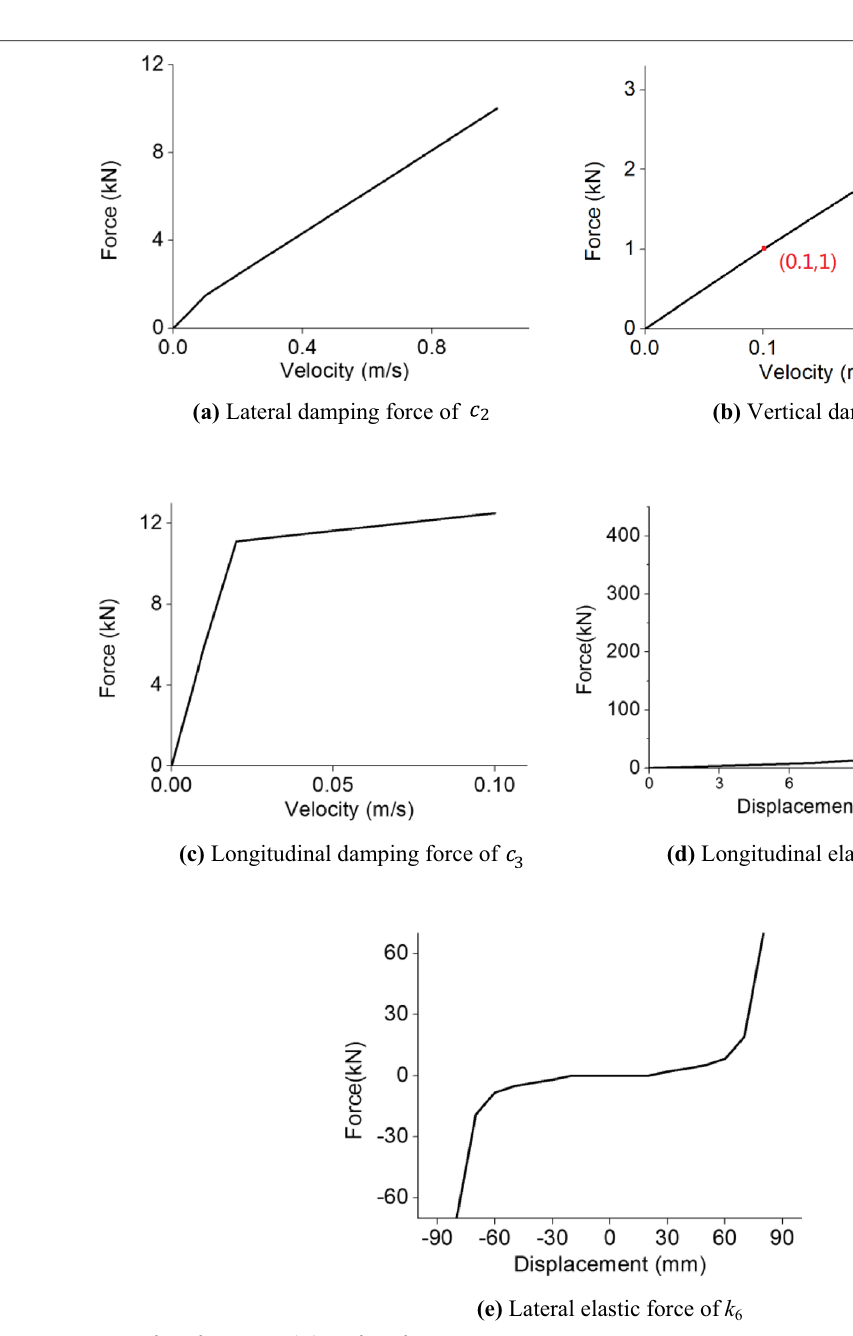
Figure 7 Damping force function and Elastic force